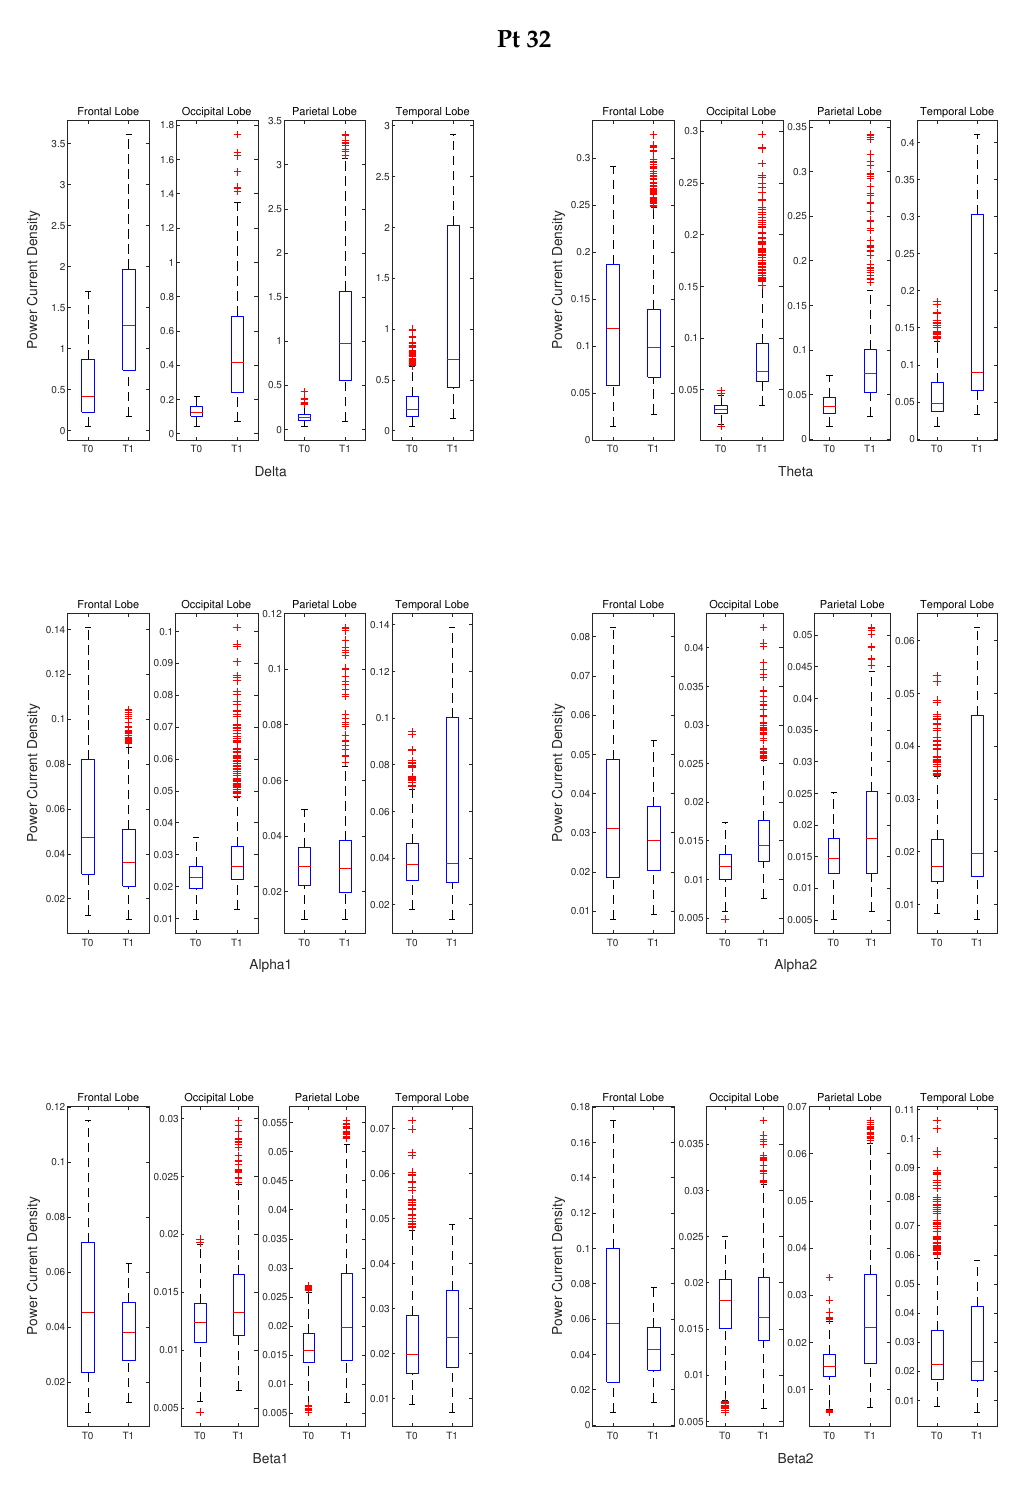
Figure 3. Boxplot of the power current density of patient 32 at time T0 and T1 for each frequency sub-band and each region of interest (frontal, occipital, parietal, and